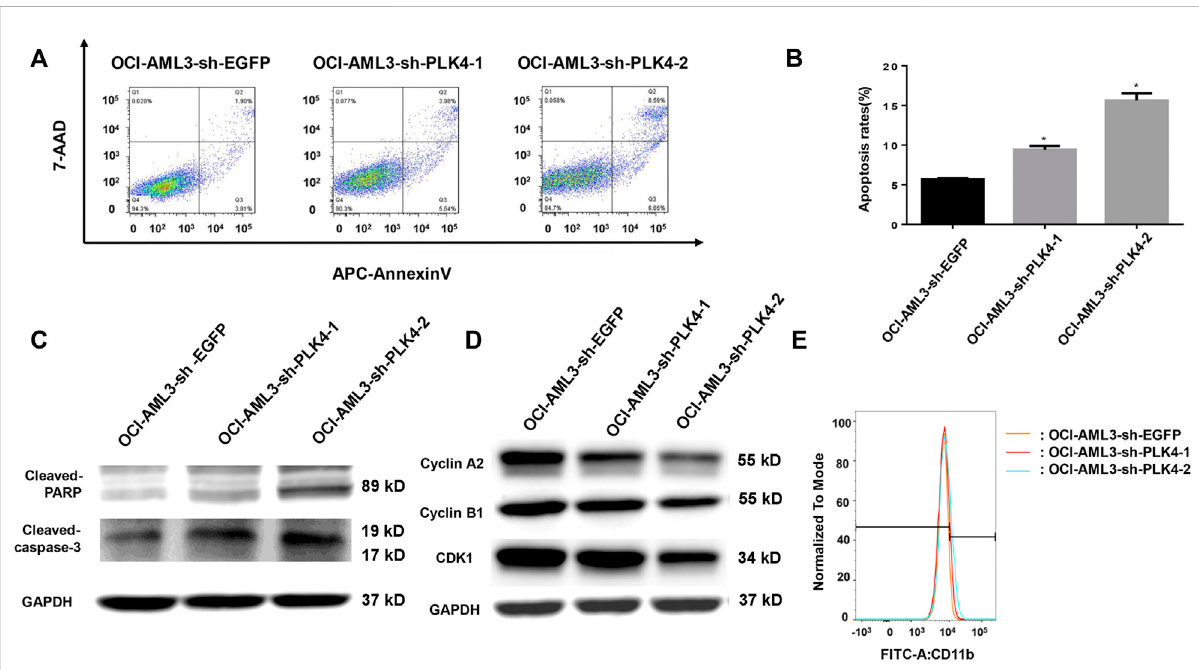
FIGURE 8 Knockdown the expression of PLK4 induced the apoptosis and the cell cycle arrest of OCI-AML3, while had no effect on the differentiation of OCI-AML3 cells. (A) The apoptosis of each group was analyzed by fl ow cytometry with Annexin V/7-AAD double stain. (B) Statistical analysis of the apoptosis of PLK4 knockdown OCI-AML3 cells (compared with the control group, * p < 0.05). (C) The expression of cleaved Caspase-3 and cleaved PARPwasdetectedbyWesternblot. (D) TheexpressionofCyclinA2,CyclinB1andCDK1wasdetectedbyWesternblot. (E) EffectofPLK4onthe differentiation of OCI-AML3 cells were stained with FITC CD11b and analyzed by fl ow cytometry.